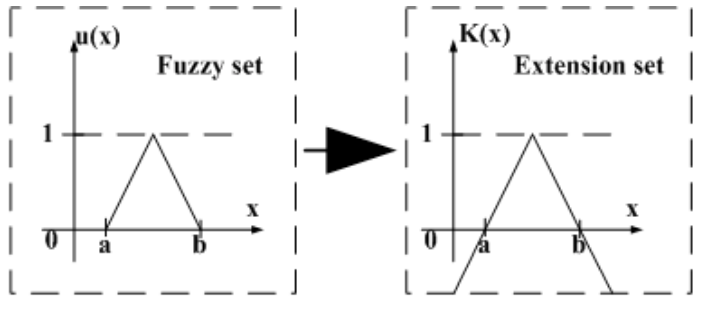
Figure 6. The fuzzy and extension sets.